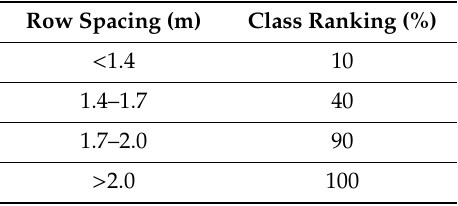
Table 5. Categorisation by mechanical accessibility of the row spacing width in Italian vineyards.